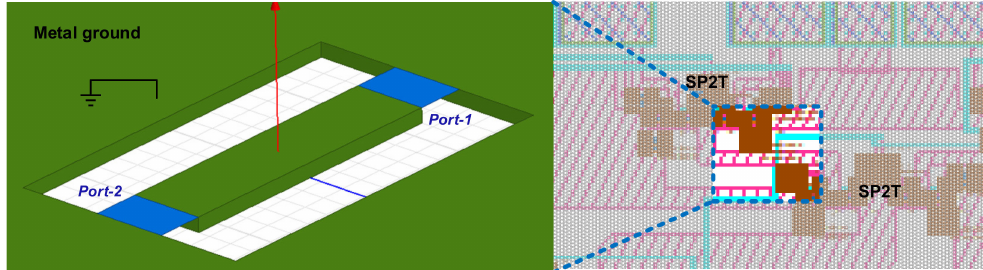
Figure 3. The simulation setup for the transmission line utilized in this